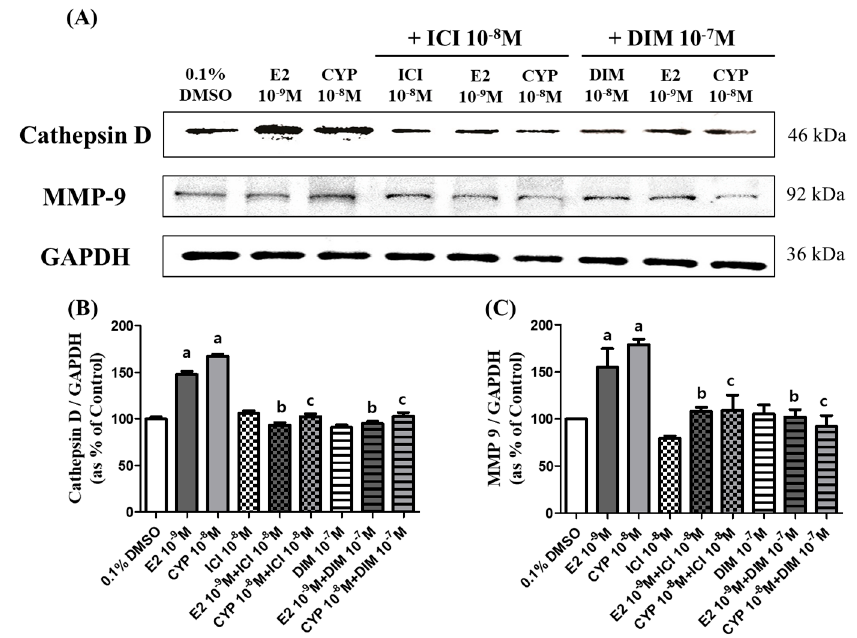
Figure 6. Effects of E2, CYP, ICI 182,780, and DIM on the expression of metastasis related genes. Ishikawa cells were treated with 0.1% DMSO, E2 (10 − 9 M), CYP (10 − 8 M), a mixture of E2 (10 − 9 M) or CYP (10 − 8 M) and ICI (10 − 8 M), or a mixture of E2 (10 − 9 M) or CYP (10 − 8 M) and DIM (10 − 7 M), respectively, for 72 h. Total proteins were extracted and analyzed by Western blot. ( A ) Band images correspond to Cathepsin D and MMP-9 proteins. Quantification of bands corresponding to ( B ) Cathepsin D and ( C ) MMP-9 proteins was conducted using Luminograph II. The experiment was repeated three times, and data are presented as the means ± SD. a: significant augmentation or reduction in expression of each protein by E2 and CYP compared to the control ( p < 0.05 according to Dunnett’s multiple comparison test); b: significant reduction in expression of each protein by the mixture with DIM or ICI and E2 compared to E2 alone ( p < 0.05 according to Dunnett’s multiple comparison test); and c: significant reduction in expression of each protein by the mixture with DIM or ICI and CYP compared to CYP alone ( p < 0.05 according to Dunnett’s multiple comparison test).